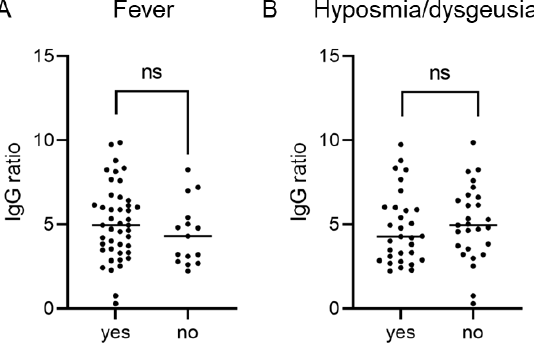
Figure 4. SARS-CoV-2 IgG anti-S ratio levels are independent of a COVID-19 disease course with or without fever ( A ) and with or without hyposmia and/or dysgeusia ( B ).